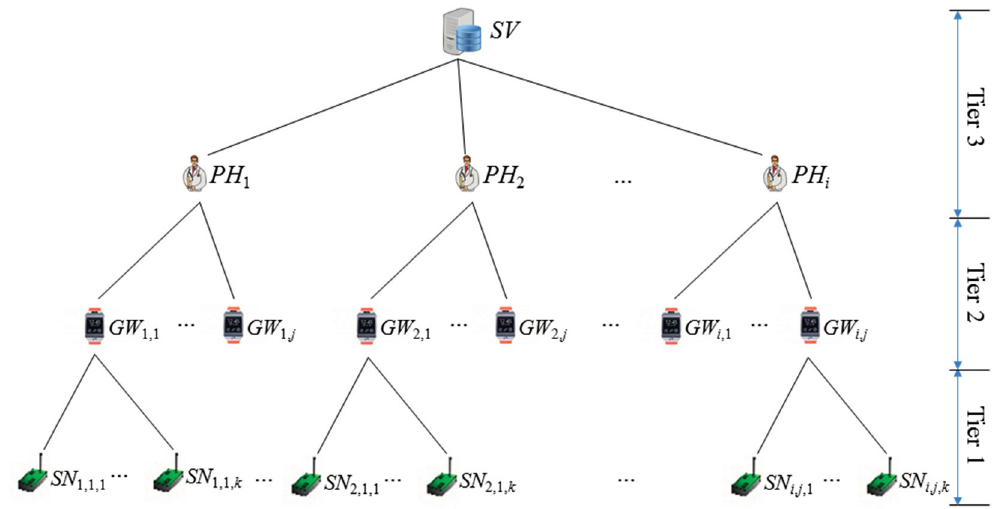
Figure 2. Permission hierarchy of a